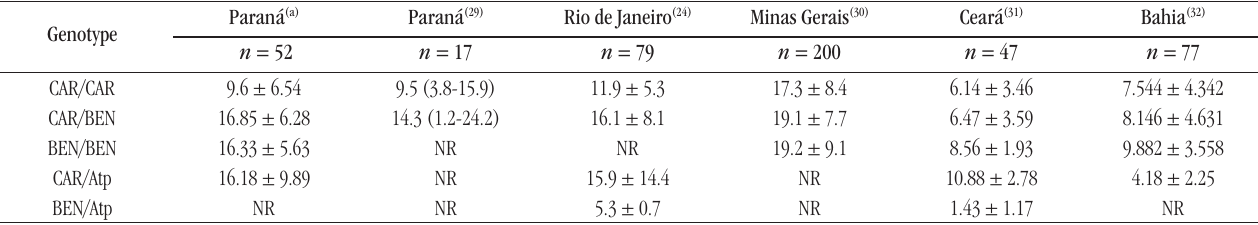
taBLE 5 − HbF in HbSS patients from different Brazilian states